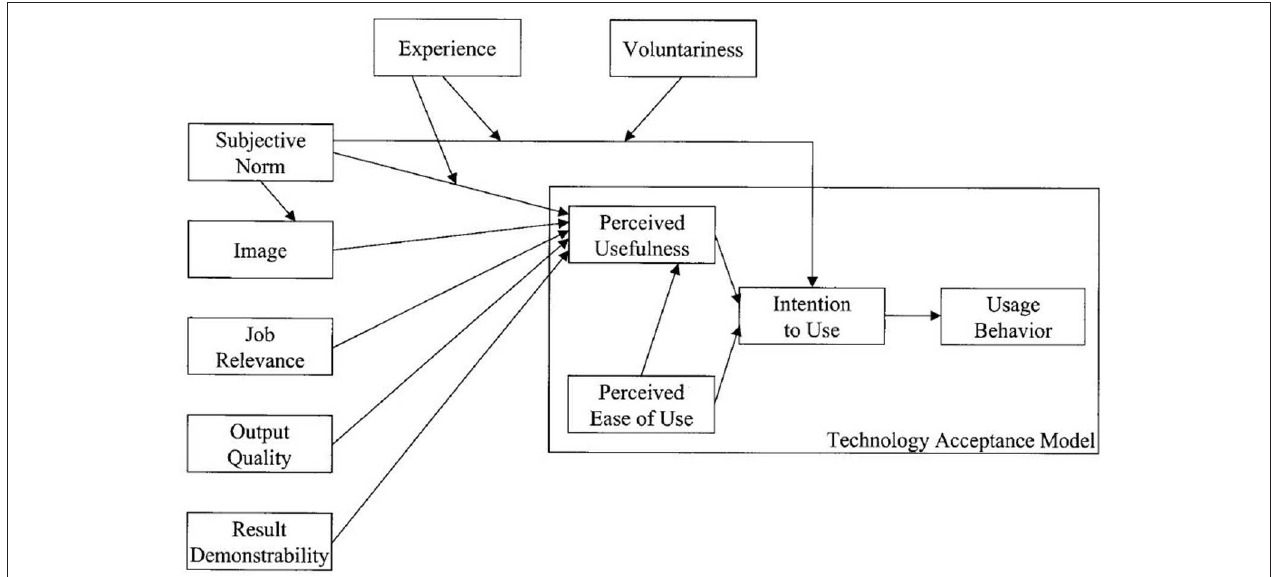
FIGURE 1 | Original technology acceptance model (TAM2/UTAUT) (Venkatesh and Davis,